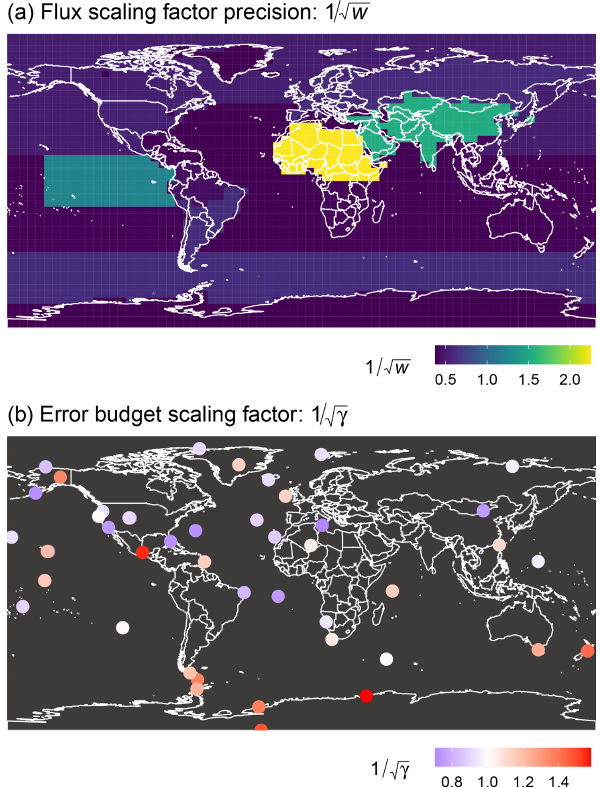
Figure 8. The inferred hyper-parameters transformed into a stan- dard deviation scale. The shading in (a) represents the mean un- √ w ) which is solved for each certainty in the prior emissions (1 / TransCom region on an annual basis. The coloured dots in (b) rep- √ γ ) which is solved resent the mean error budget scaling factor (1 / for each measurement